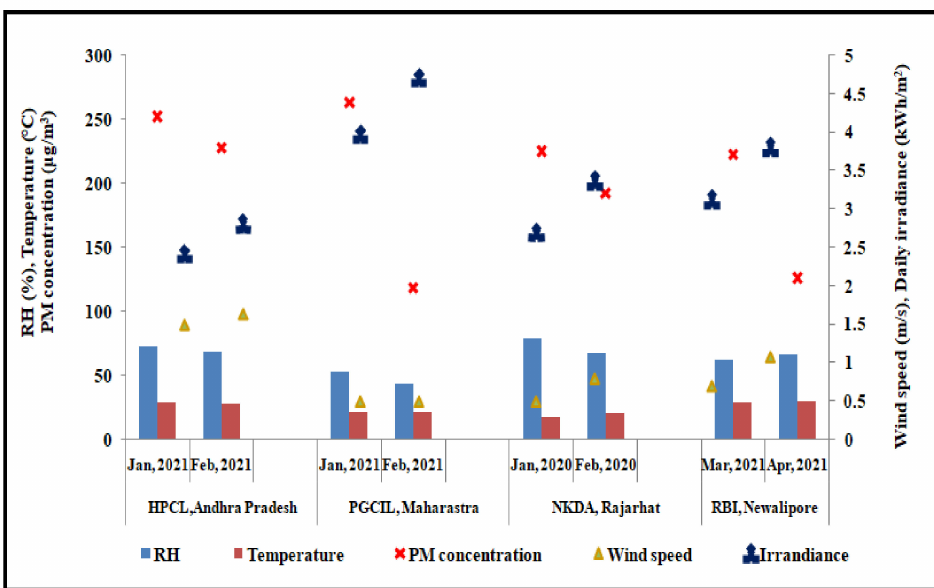
Figure 3. Climatic conditions for different location for the time period of